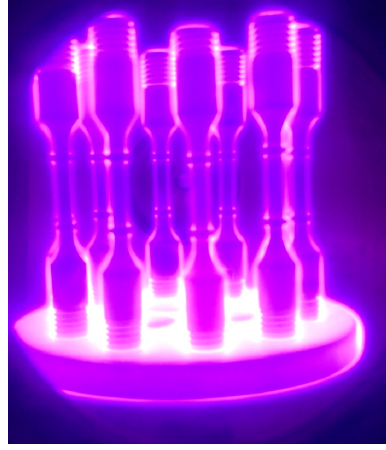
Figure 1. Sample holder drawing used for plasma nitriding.